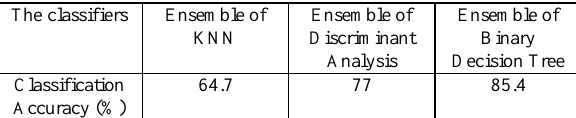
Figure 2. The general scheme of the proposed method for the classification. Table 1. The obtained classification accuracies .